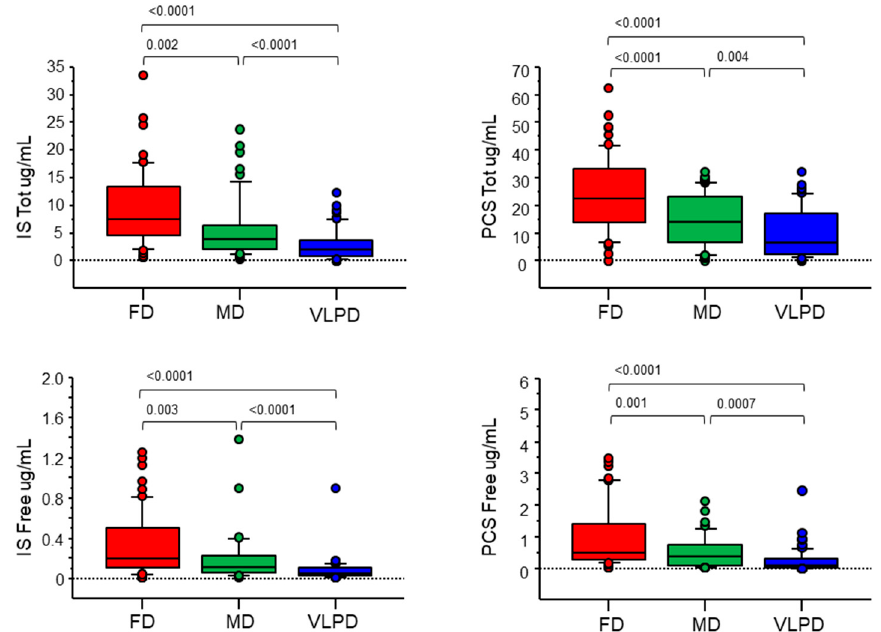
Figure 5. Serum levels of IS and PCS measured by MRM MS analysis. Serum levels of IS and PCS in CKD patients according to the different dietary regimens (Table 1). In the diagrams, the 25th and 75th percentiles are plotted as box, the 90th and 10th percentiles as bars, and observations less than the 10th percentile and greater than the 90th percentile as points. The central horizontal line within each box represents the 50th percentile. p values were calculated by Wilcoxon test.